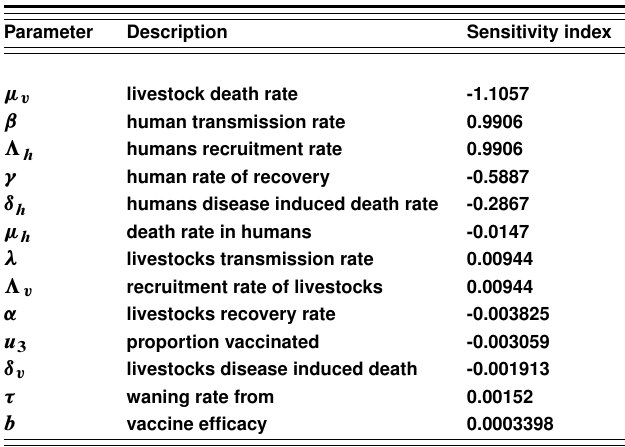
Table 2. Sensitivity indices of model parameters to R